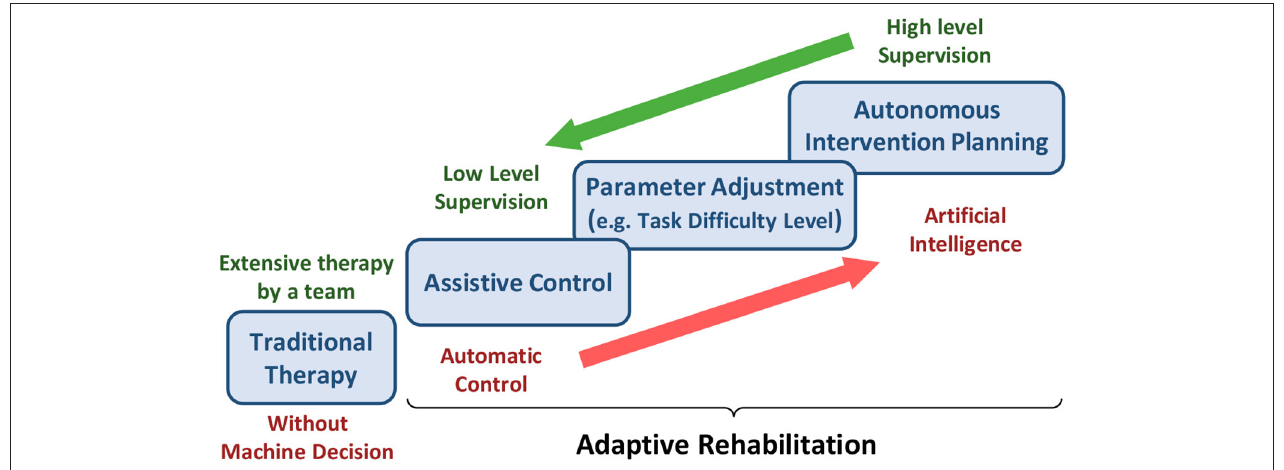
FIGURE 4 | The burden of assistance and decision-making shared between experts and machines from traditional therapy to adaptive